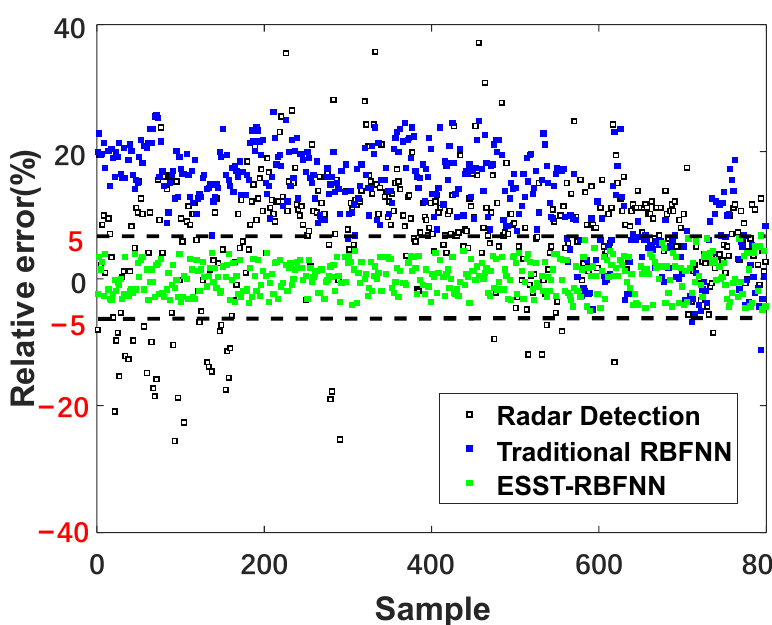
Figure 12. Compassion diagram of relative error.